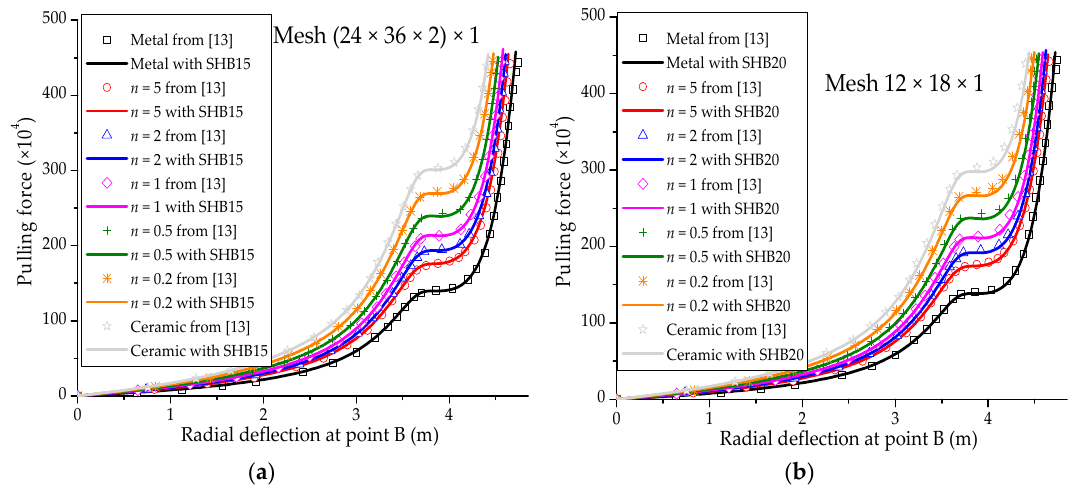
Figure 16. Radial displacement at point B under concentrated force for the open-ended cylinder. ( a ) prismatic SHB15 element; ( b ) hexahedral SHB20 element.